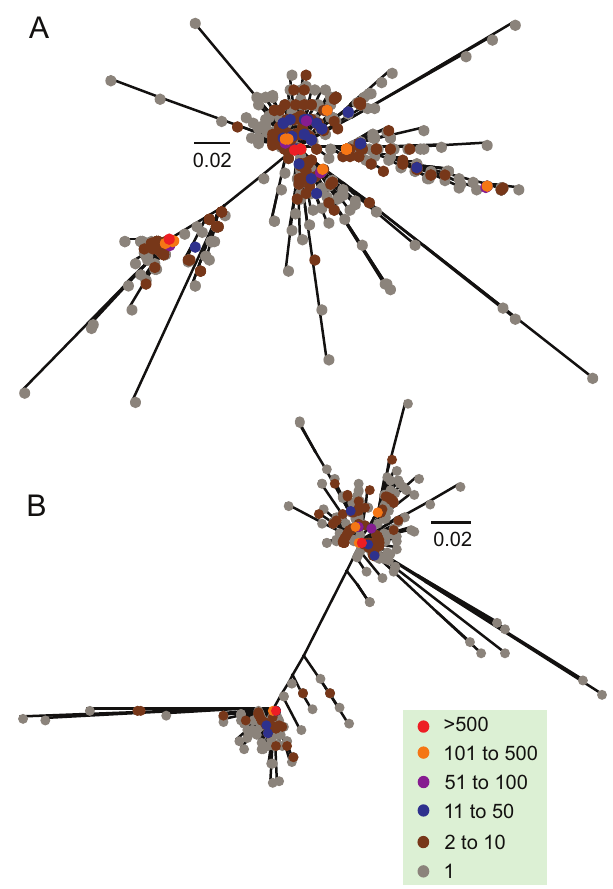
Figure 5. Frequency of HIV-1 variants in the phylogenetic trees. Evolutionary tree inferred from all patient D’s V3 nucleotide sequences (A), and all patient E’s V3 nucleotide sequences (B). Colors (see key) indicate the frequency of each sequence. The scale bar represents nucleotide substitutions per site.